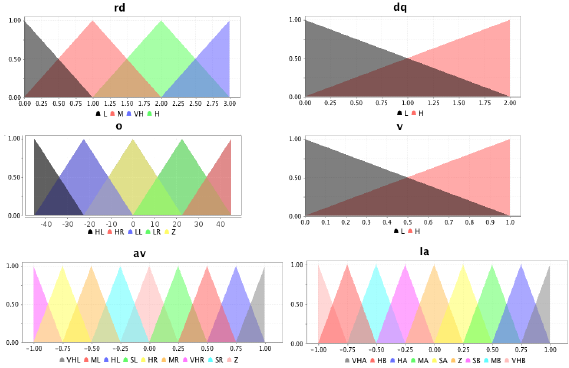
Fig. 8. Membership functions for a wall-following